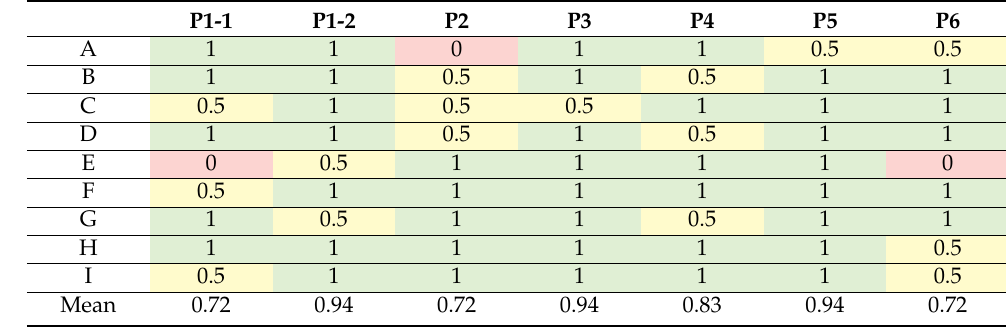
Table 10. Paraphrasing levels for each key idea. Px stands for the paraphrasing level of the student with regard to key idea x, cf. Tables A1–A6. The responses are color coded such that 1 is green, 0.5 is yellow and 0 is red.